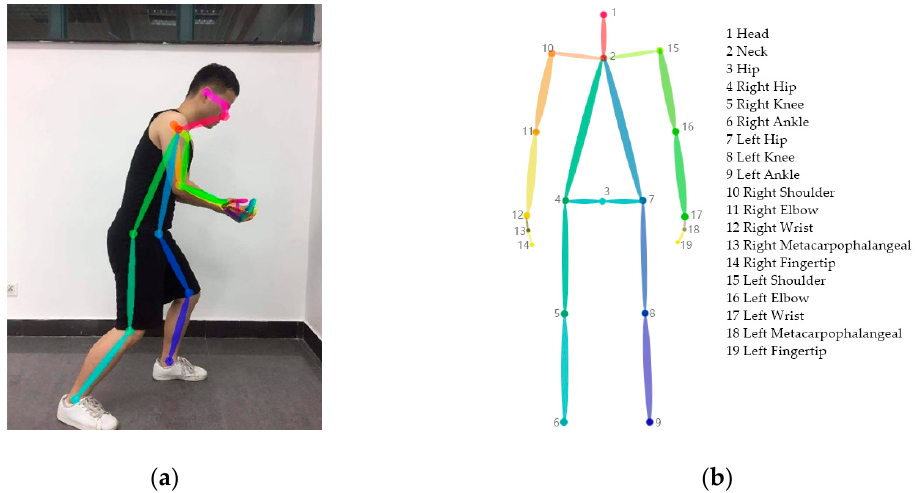
Figure 2. Human skeleton model provided by convolutional pose machines (CPM) ( a ), and the human skeleton model and joint point number required for evaluation ( b ).